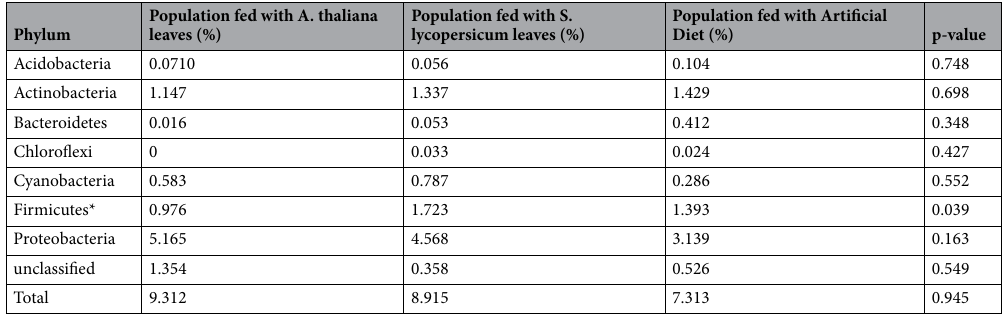
Table 3. Phyla-level bacterial diversity in each diet administered Trichoplusia ni during experimentation. *ANCOVA univariate test (P < 0.05). The amount of bacterial diversity observed in each population corresponds to the numbers of ASVs classified at the phyla level to visualize sample alpha diversity with Shannon’s diversity index in the row described “total”. Asterisks indicate statistically significant differences among all pairs of values. (*) p <